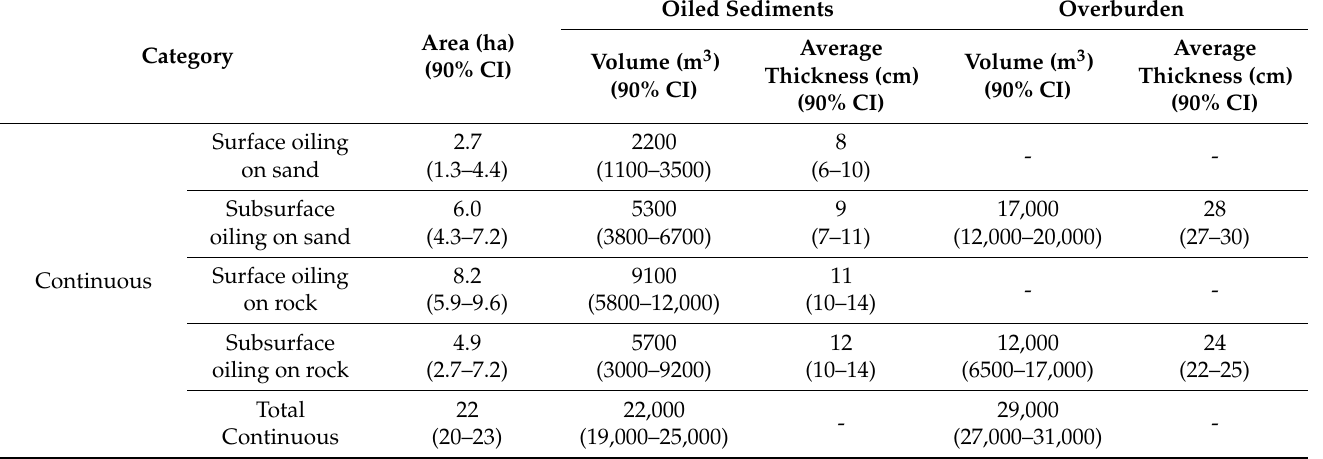
Table 2. Model-estimated areal extent (hectares; ha), volume, and average thickness of intertidal oiled sediments and clean sediment overburden by location (subsurface or surface) and substrate (rock or sand) for continuous and discontinuous oiling. All values reported to two significant digits for volume and area and rounded to nearest whole integer for thickness. Totals may not precisely sum due to rounding in reported values. Empirical 90% confidence intervals derived from Monte Carlo